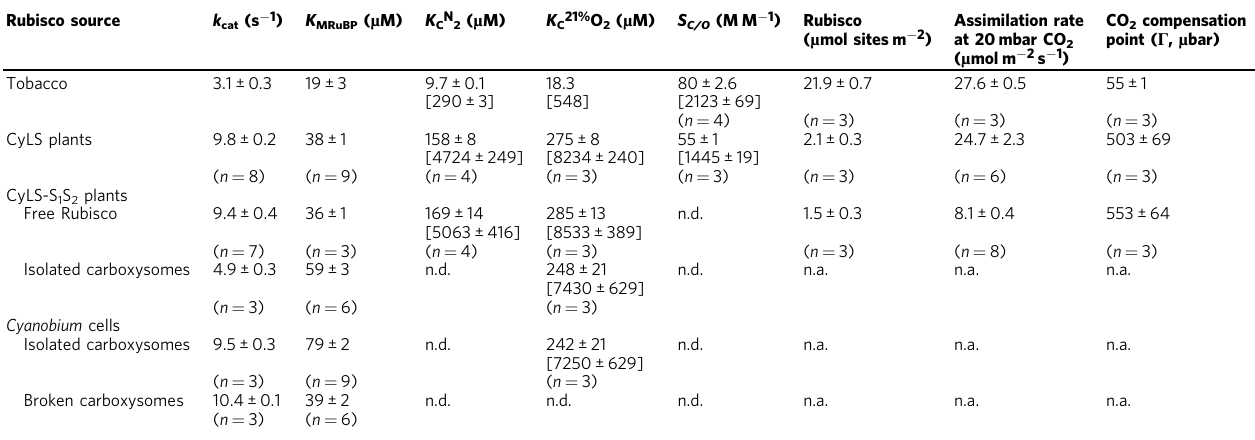
Table 2 Rubisco catalytic properties, leaf Rubisco content and photosynthetic performance Rubisco